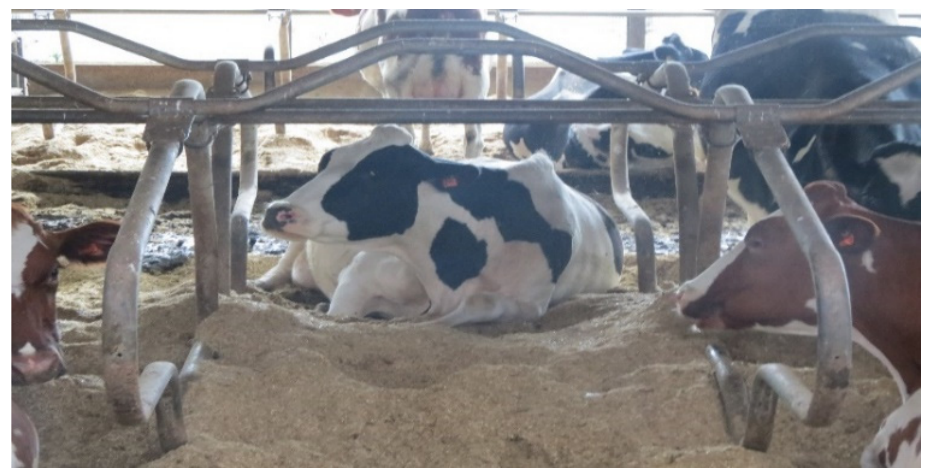
Figure 1. Cubicle barn for dairy cows.